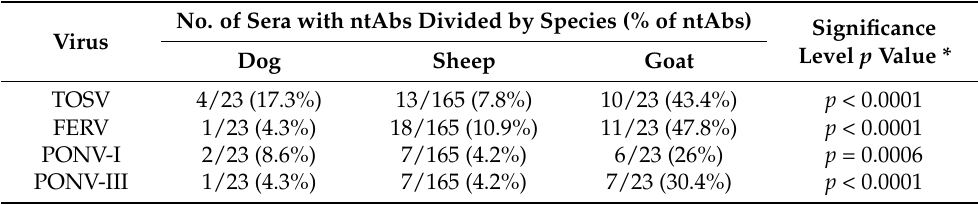
Table 2. Prevalence of neutralizing antibodies for each virus and species. No. of Sera with ntAbs Divided by Species (% of Virus